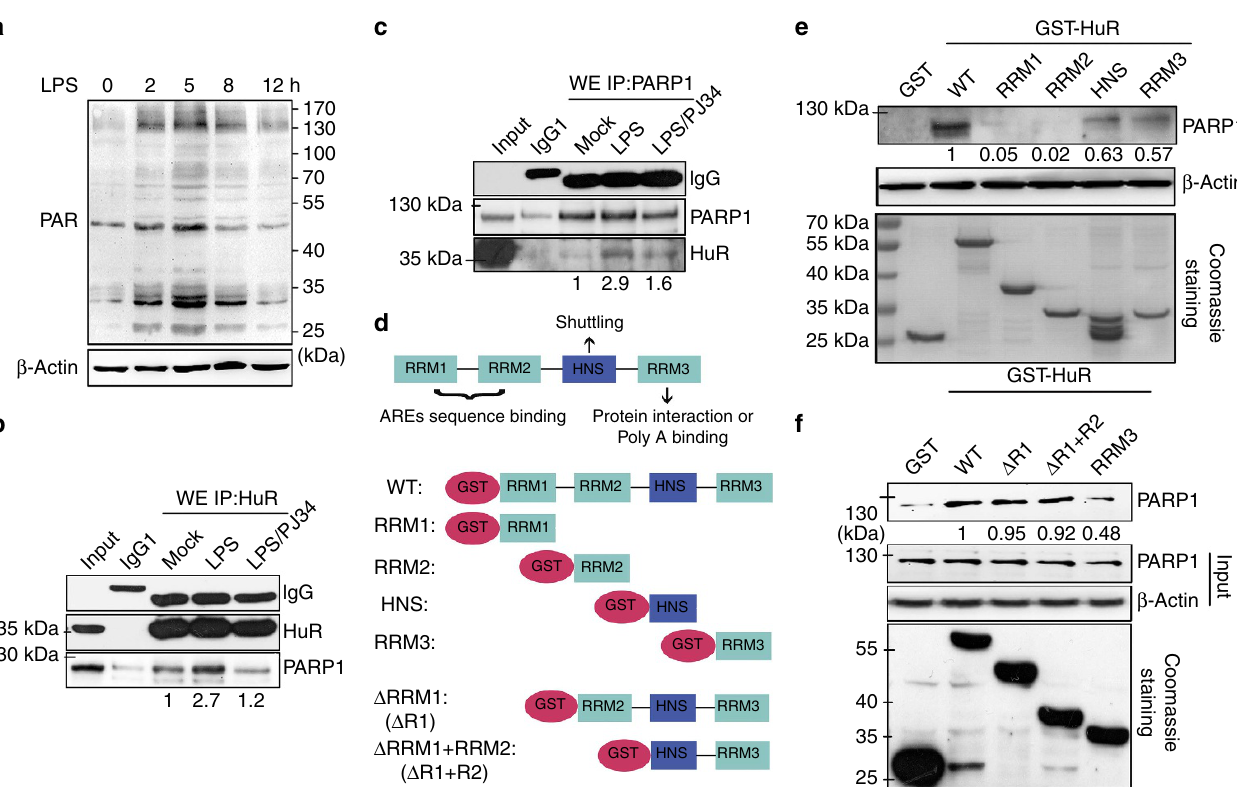
Figure 2 | PARP1 interacts with HuR in response to LPS exposure. ( a ) LPS stimulation promotes protein PARylation. RAW 264.7 cells were challenged with LPS for various lengths of time. Immunoblotting was performed to detect the PARylation levels of proteins in whole-cell lysates. ( b , c ) LPS exposure increases the association of PARP1 with HuR. RAW 264.7 cells were mock-treated or LPS-exposed ( ± PJ34) for 5h. Whole-cell extracts (WEs) were prepared and immuno-precipitates were obtained using antibodies recognizing HuR ( b ) and PARP1 ( c ). The association of PARP1 with HuR was detected by immunoblotting. ( d ) Diagram of the domains in HuR. The schematics of the GST-HuR expression plasmid, as well as domains and truncated mutants. ( e , f ) HNS and RRM3 mediate the association of HuR with PARP1. GSTand GST-HuR, as well as the domain ( e ) and truncated ( f ) mutants were incubated with equal amounts of WEs from LPS-treated cells. Levels of pulled down PARP1 were detected by that Cxcl2 ’s 3 0 -UTR mediates PARP1’s regulation of mRNA